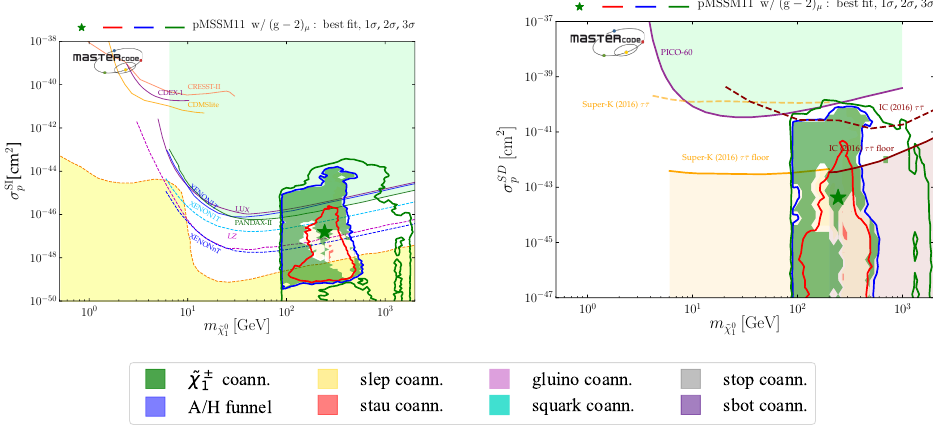
Figure 2. Upper plot: m – σ SD p plane; for the various lines and shaded areas: see text. Lower plot: ˜ χ 0 1 m – σ SD p plane; for the various lines and shaded areas: see text. In both plots the red, blue and ˜ χ 0 1 green solid lines indicate the 1, 2, 3 σ preferred parameter regions, respectively, with the best-fit point shown as a green star. The color coding within the 2 σ area correspond to the DM relic density mechanism. Taken from